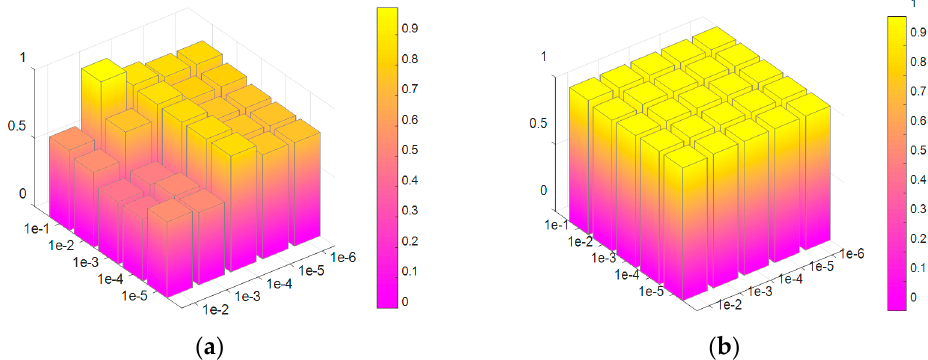
Figure 3. Average results of ACC and AUC versus parameter λ 2 and λ 3 . ( a ) ACC results. ( b ) AUC results.